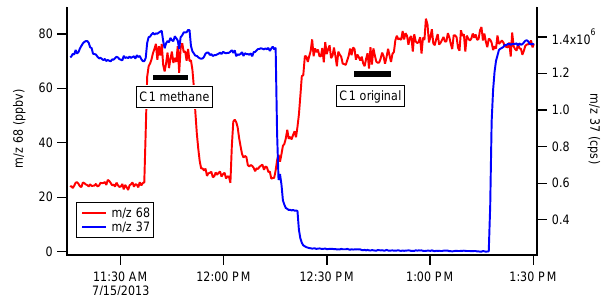
Figure 5. Comparison between C1 acquired with the OH scavenger approach and with the original approach. Values of m/z 37 refer to the protonated first water cluster which is used as tracer for abso- lute humidity in the system and depends on PTR-MS operational conditions, in our case E/N =